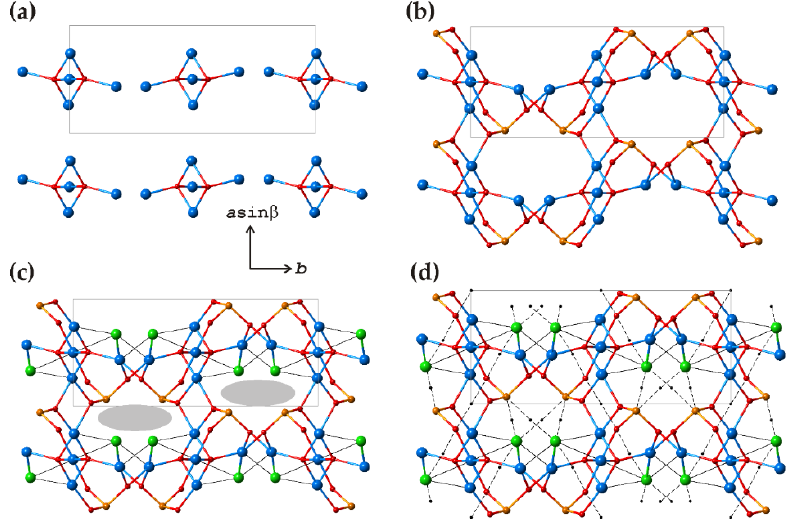
Figure 5. The scheme of successive (step-by-step) construction of the crystal structure of georgbokiite, α-Cu 5 O 2 (SeO 3 ) 2 Cl 2 : ( a ) the arrangement of the [O 2 Cu 5 ] chains of edge- and corner-sharing (OCu 4 ) tetrahedra; ( b ) the metal-oxide bonding network of the Cu–O and Se–O bonds; ( c ) the structure projection showing the positions of the Cl atoms and the location of extended channels parallel to [001] (shown in gray); ( d ) the location of bcps corresponding to weak closed-shell interactions. See text for details. Legend: Cu, Se, O, and Cl atoms are shown as blue, orange, red, and green spheres, respectively. Small black spheres indicate the positions of